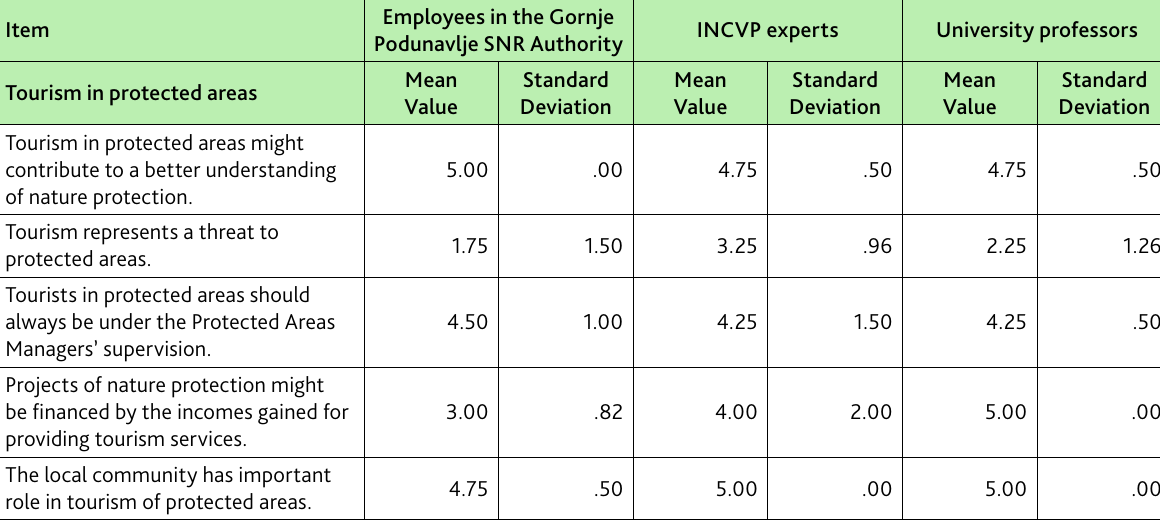
Table 1. Respondents’ attitudes on tourism in protected areas